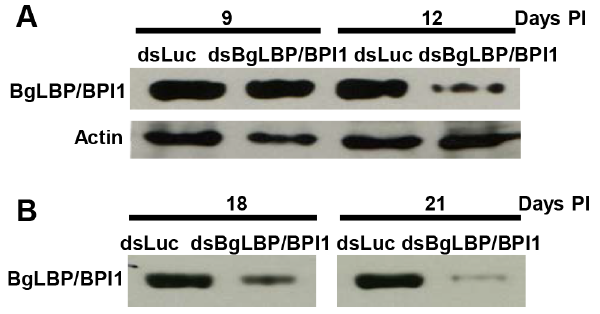
Figure 6. Injection of BgLBP/BPI1 dsRNA results in a substantial decrease in BgLBP/BPI1 protein in the albumen gland and in egg masses. (A) Western blots of albumen glands from snails at 9 days and 12 days post injection (Days PI) of dsRNA of luciferase (non-relevant dsRNA) (dsLuc) or BgLBP/BPI1 (dsBgLBP/BPI1). Actin was used as an endogenous control for protein loads. (B) Western blots of egg